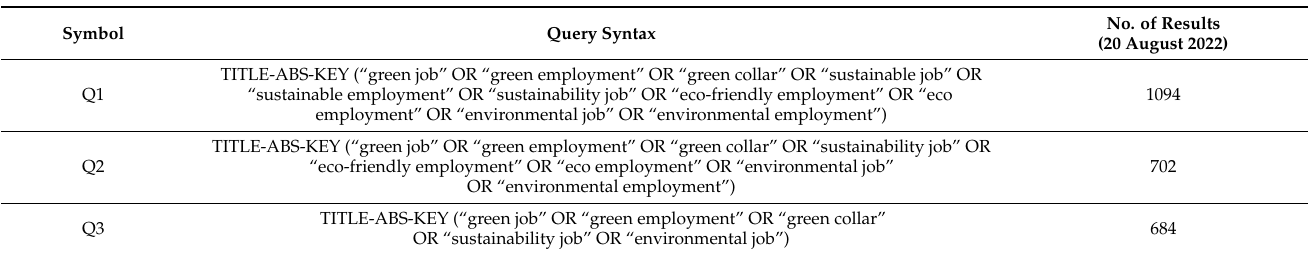
Table 1. Queries focused on typologies used in the Scopus scientific database exploration on 20 August 2022.